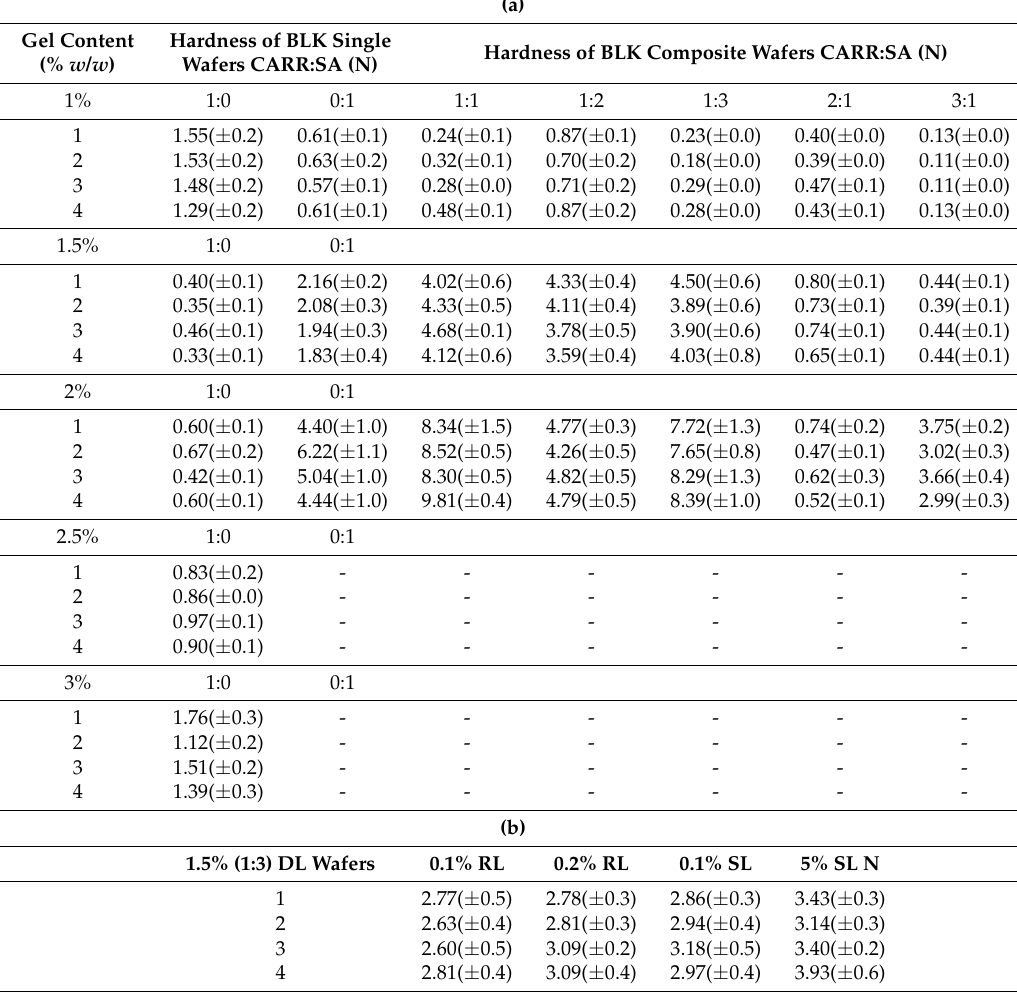
Table 2. Hardness profiles of ( a ) BLK freeze-dried wafers prepared from different single polymer and composite gels at different total polymer concentrations (1–3%) and ( b ) BSs-loaded wafers prepared from 1.5% CARR:SA (1:3) composite gel ( n =